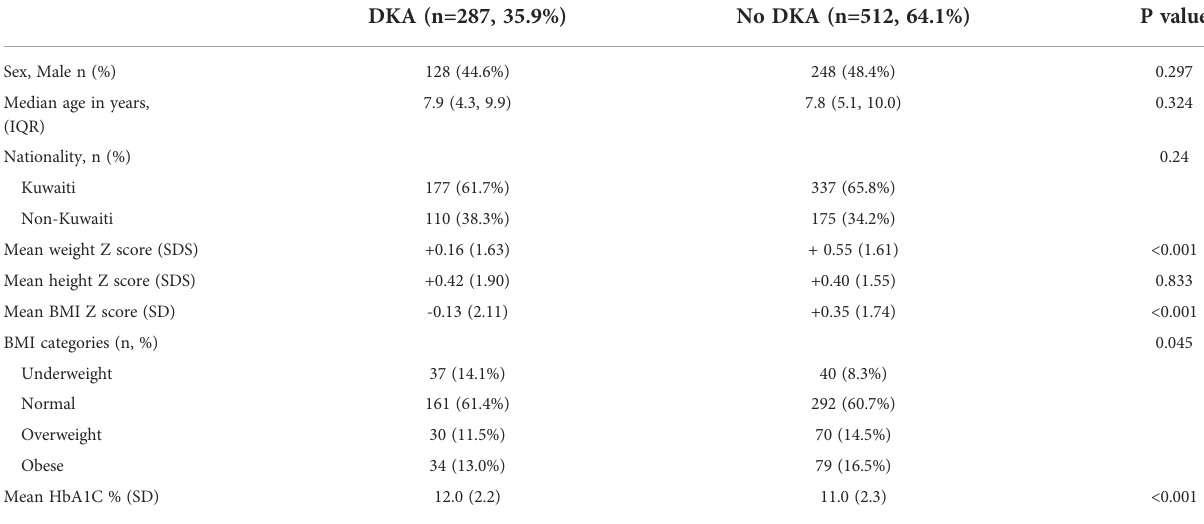
TABLE 2 Characteristics of children presenting with DKA compared those who did not present with DKA at diagnosis with T1D in Kuwait. DKA (n=287, 35.9%) No DKA (n=512,